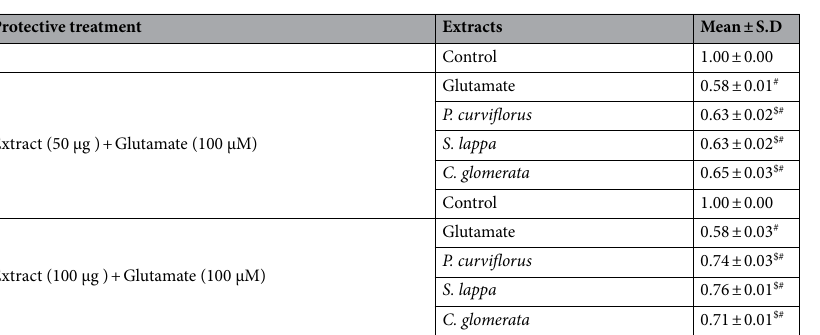
Table 4. The protective effects of 50 µg and 100 µg of the three plant extracts in improving cell viability of 100 µM glutamate-treated cells. Comparing between all groups using One-Way ANOVA test with Multiple Comparisons (Dunnett test) to compare each group with the glutamate group. $ p < 0.001, value between each group and the control group. # p < 0.001 value between all